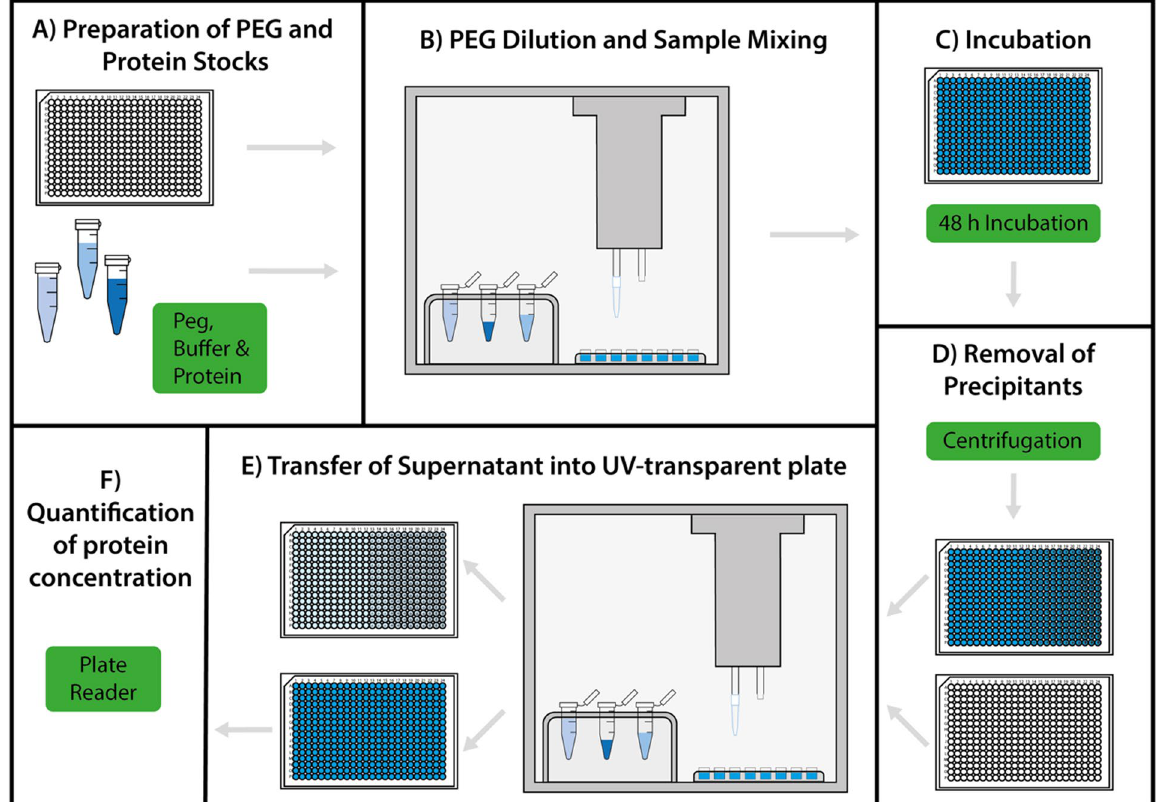
Figure 1. Outline of the procedure described in this article for the measurement of protein relative solubility using an automated PEG assay. (A) All necessary material, including buffer, PEG solutions, proteins and an empty plate are prepared. (B) The robot titrates PEG and performs sample mixing for a final well volume of 10 µL. ( C) After sealing, the plate is incubated for 48 h at 4 °C. (D) The precipitates are separated from the solution by centrifugation. (E) The supernatant is transferred into a freshly prepared UV-transparent plate. (F) The protein concentration in the supernatant (i.e. the soluble concentration) is estimated with absorbance measurements carried out with a plate